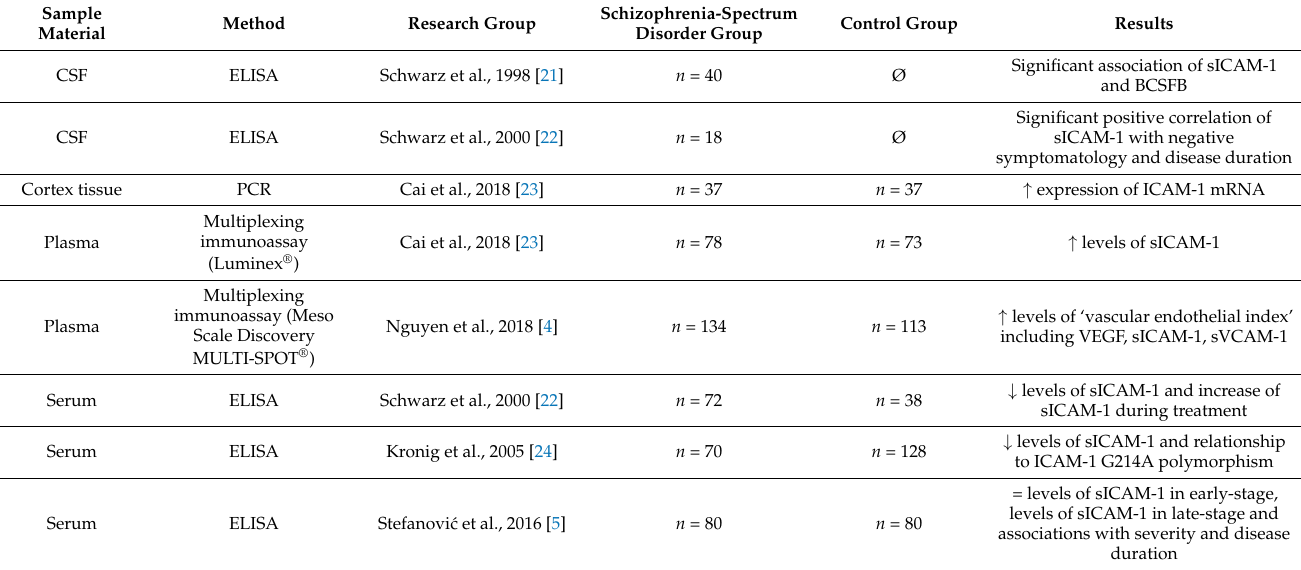
Table 1. Overview of findings measuring levels of sICAM-1 and sVCAM-1 in patients with schizophrenia-spectrum disorders (reviewed by Müller, 2019